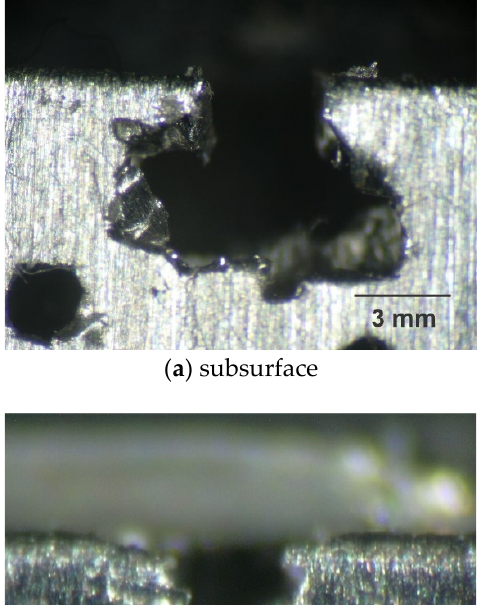
Figure 10. Histogram of the number of pits per analyzed area after the corrosion test for the A1 ( a ) and B1 ( b ) samples.